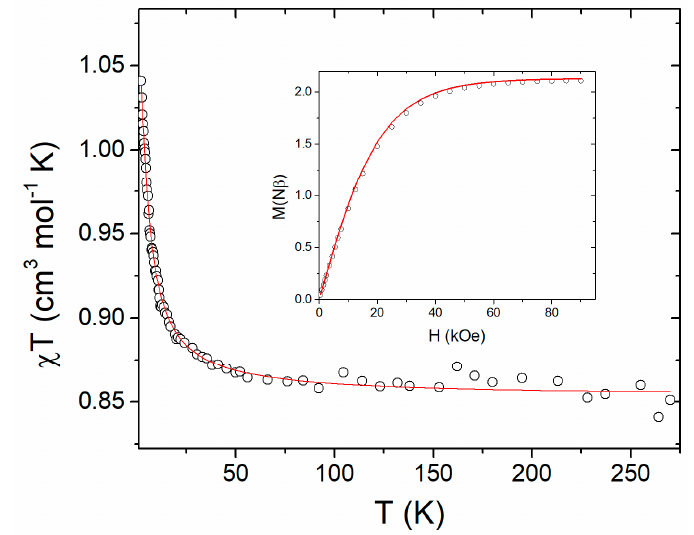
Figure 5. χ M T vs. T and M vs. H at 2.0 K (inset) for 1 . The solid lines correspond to the calculated curves using the best fit parameters described in the text.